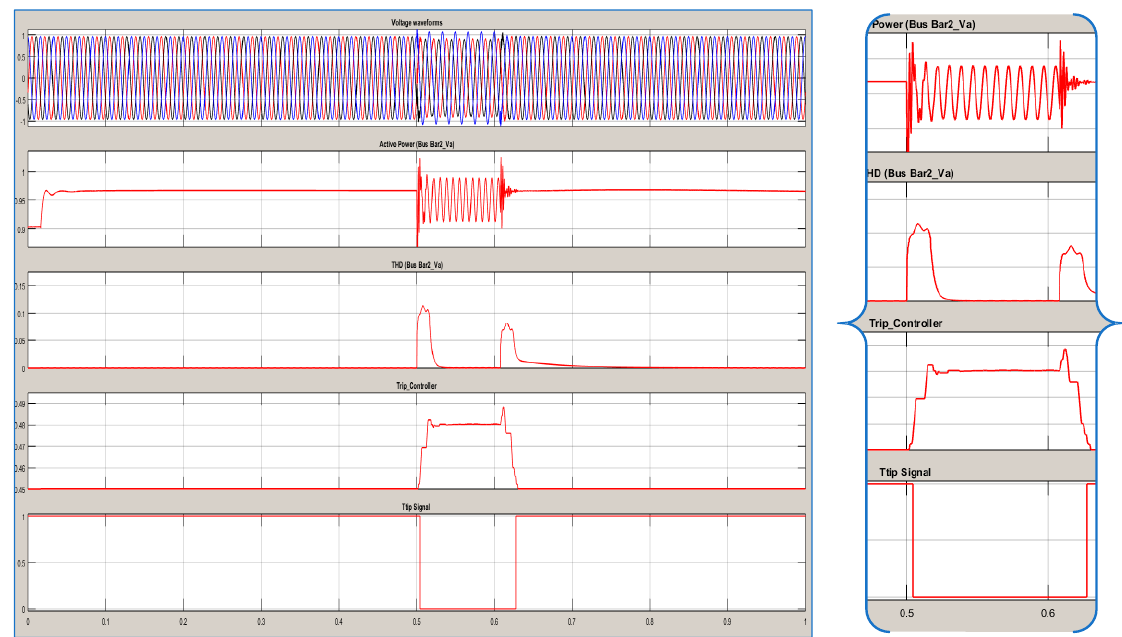
Figure 11. Single line to ground (B_G) fault voltage waveform.